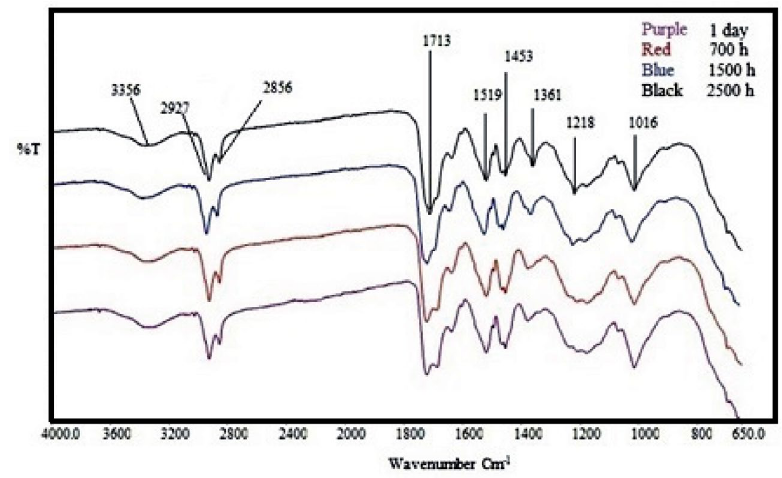
Figure 10. FTIR spectrum of the polyaspartic coating of sample